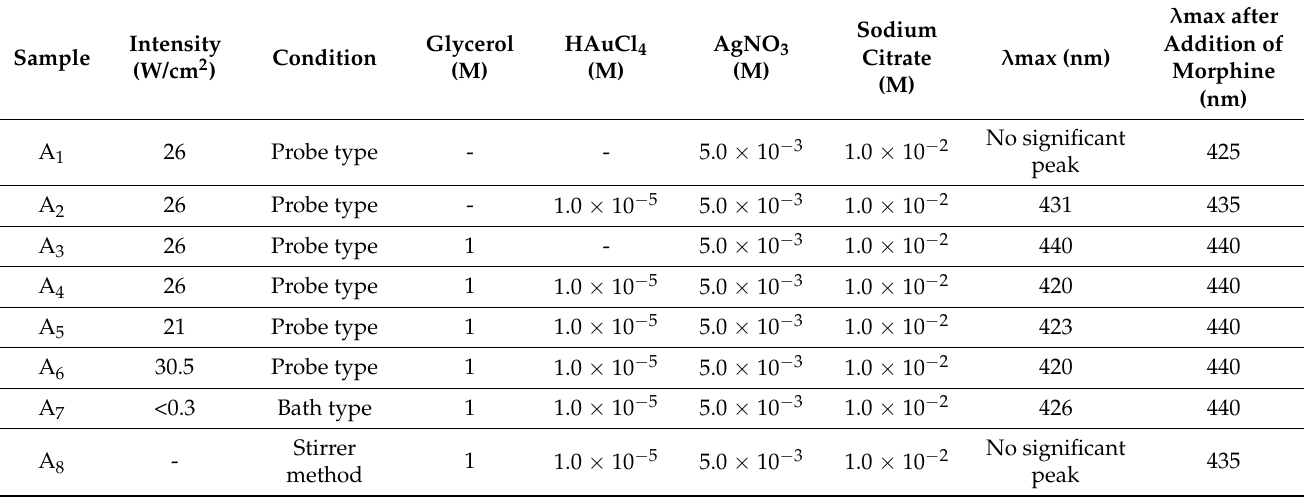
Table 1. Synthesis conditions for the Au@Ag NPs, and test results in the sensing of